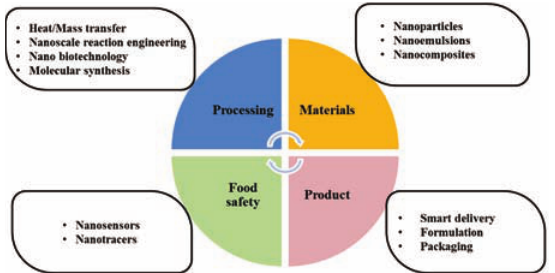
Fig. 5 Applications of Nanotechnology in food sector (adapted from (Weiss, 2006)).